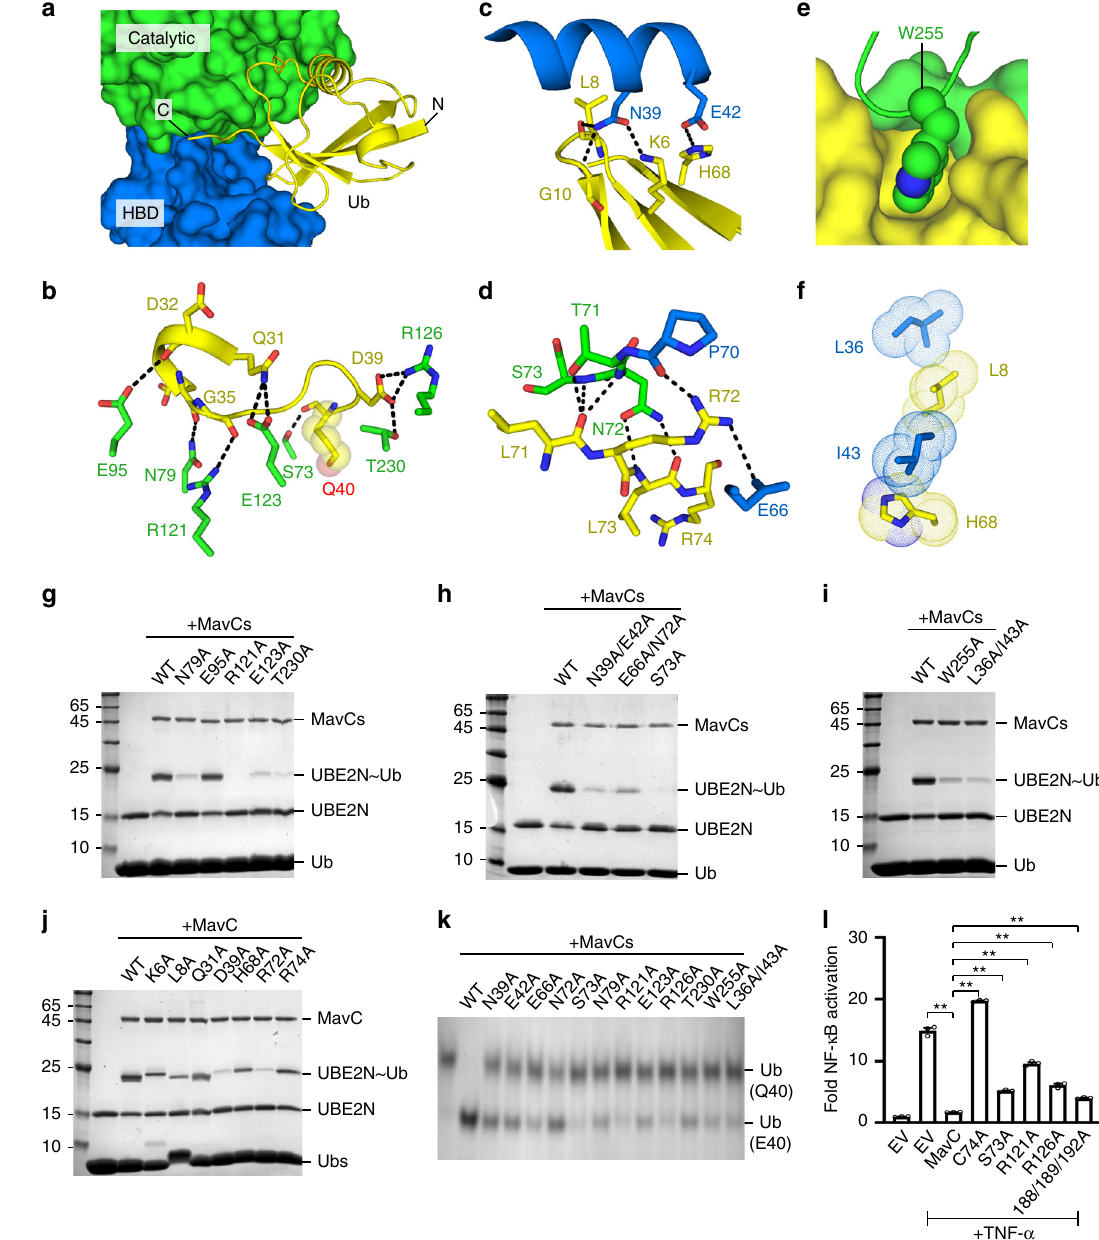
Fig. 3 Interactions between MavC and Ub. a Overall view of Ub (cartoon; yellow) binding within the cleft of Catalytic (surface; green) and HBD (surface; blue) domains of MavC. b – d Three major regions of hydrogen bonding interactions between MavC and Ub, same color code as in a . The hydrogen bonds were shown in black dash lines. e , f Two major regions of hydrophobic interactions between MavC and Ub, same color code as in a . g – i In vitro ubiquitination reactions for various MavC mutants on different MavC – Ub inter-molecular interacting surfaces. The reaction mixtures were subjected to SDS-PAGE and stained with Coomassie dye. j Indicated Ub proteins were incubated with MavC and UBE2N. The reaction mixtures were subjected to SDS- PAGE and stained with Coomassie dye. k In vitro Ub deamidation reactions for various MavC mutants. The reaction mixtures were subjected to native- PAGE and stained with Coomassie dye. l Mutations on MavC decreased its inhibition ability to NF- к B activation in cells. Plasmids encoding MavC or its mutants were co-transfected with NF- к B luciferase reporter system plasmids. Cells were mock-treated or treated with TNF- α . The luciferase activities were measured for the activation of NF- к B reporter (see details in Methods). Data presented are means ± SEM of three independent experiments. ** p < 0.01, unpaired and two-tailed t test. Source data are provided as a Source Data fi le. Experiments in g – l were repeated independently three times with similar To validate the importance of MavC – Ub interactions, we UBE2N ubiquitination (Fig. 3g). Similarly, mutations on the generated multiple MavC mutants covering all of the above second (Fig. 3c) and third (Fig. 3d) hydrogen bonding surfaces interacting surfaces and analyzed their ubiquitination activities. notably reduce the ubiquitination activities (Fig. 3h). Further- Alanine substitutions for most key residues (except E95A) of the more, alanine substitutions of the two hydrophobic surfaces fi rst hydrogen bonding surface (Fig. 3b) dramatically inhibit (W255A and L36A/I43A) also inhibit UBE2N ubiquitination